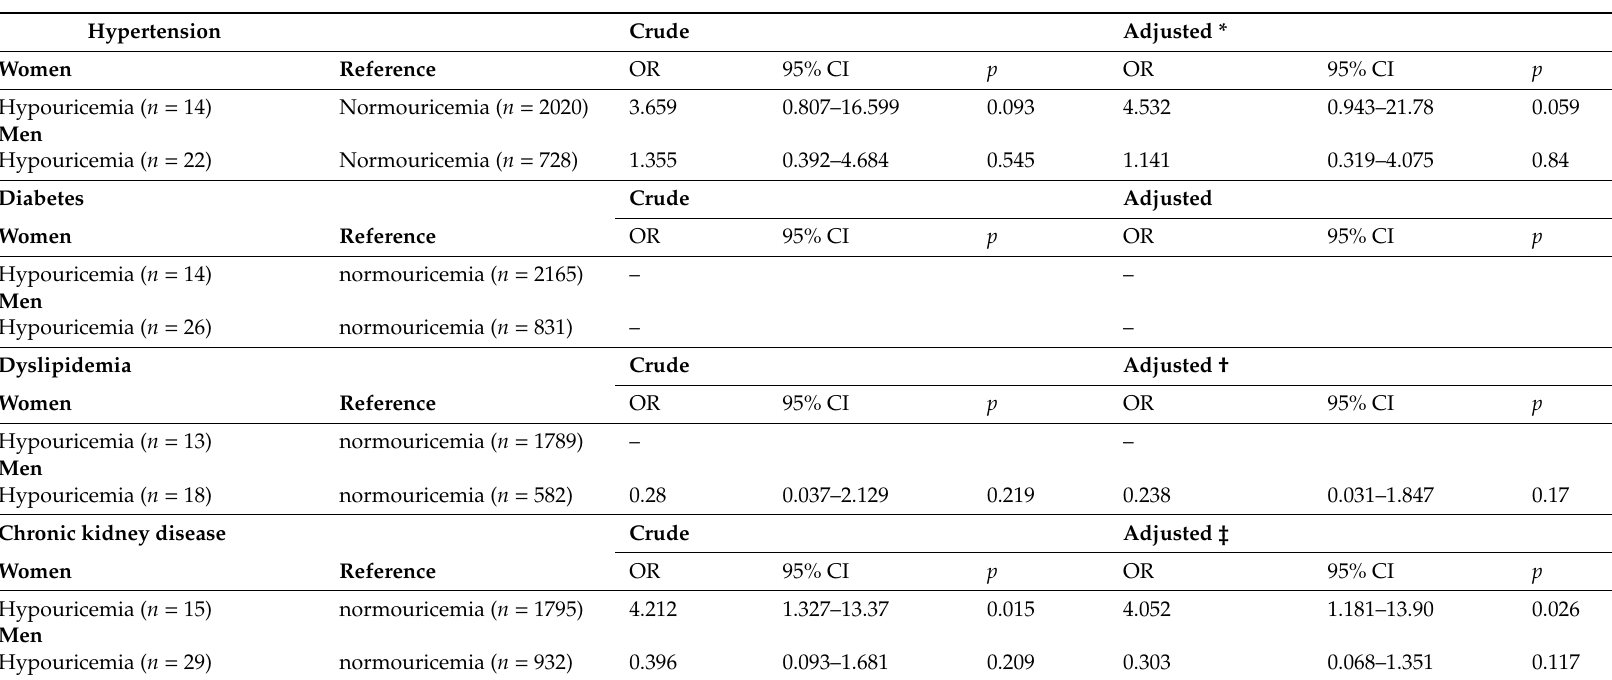
Table 4. Hypouricemia (serum urate less than 3 mg / dL in men and less than 2 mg / dL in women) as a risk factor for the development of hypertension, diabetes, dyslipidemia and chronic kidney disease over 5 years compared with normouricemia (serum urate of 3–5 mg / dL in men and 2–4 mg / dL in women).